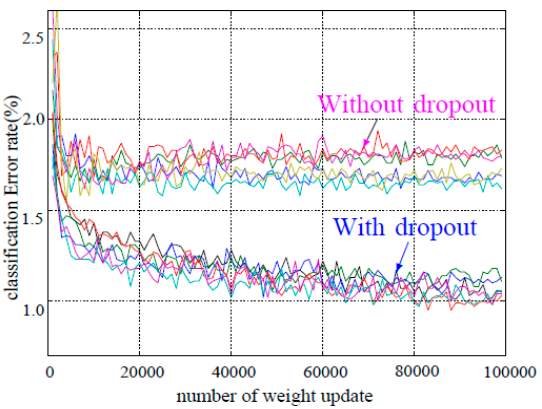
Figure 6. Test error for different datasets with and without dropout.